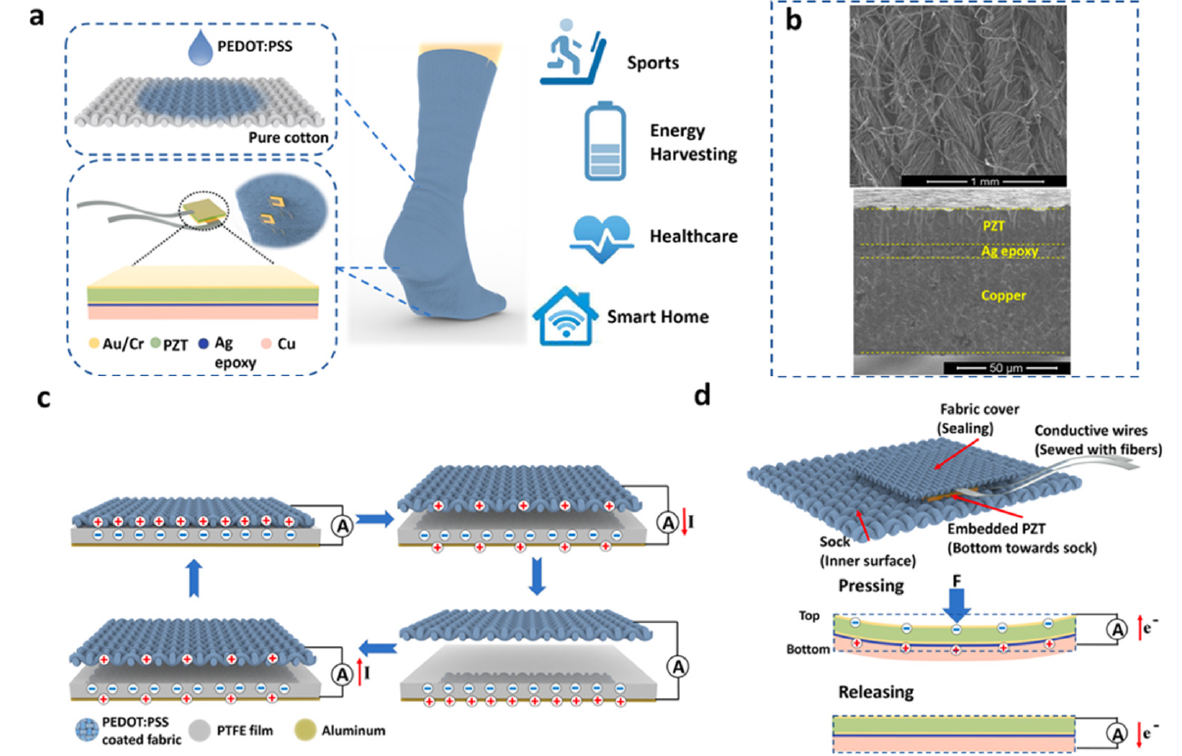
Figure 8. TENG and piezoelectric device integrated in a S 2 -sock manufactured by Zhu et al. [105]. ( a ) Schematic of the materials used in the triboelectric S 2 -sock coupled with piezoelectric devices for various applications, including energy harvesting, healthcare, smart home, and sports. ( b ) (Top) SEM image (top view) of PEDOT:PSS-coated textile. SEM image of a cross-section view of piezoelectric device. ( c ) Working mechanism of TENG sock using contact-separation condition. ( d ) Work- ing mechanism of piezoelectric device and integration design for S 2 -sock. Reprinted with permission from [105]. Copyright 2019, American Chemical Society.